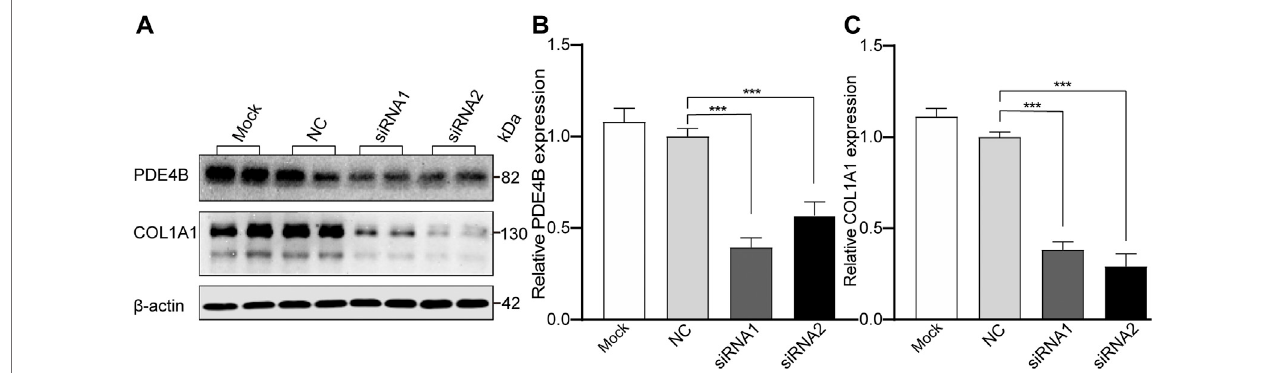
FIGURE 5 | The Effect of P DE4B Knockdown on Expression of Type I collagen (COL1A1) in cultured HSFs. The HSFs were treated with siRNA for 48 h, then the knockdownef fi ciency ofPDE4Band theexpression ofCOL1A1 wereanalyzed byWesternblot (A) . (B,C) The bar graphsrepresentrelativeprotein levels of PDE4Band COL1A1. (B) The protein expression level of PDE4B. (C) The protein expression level of COL1A1. Mock: blank control (transfection reagent only); NC, negative control (cells transfected with scrambled siRNA). β -actin was the loading control. Data were expressed as mean ± standard error (mean ± SEM), n (cid:1) 5 for each group. Comparison of the PDE4B siRNA-transfected group and scrambled siRNA group were determined by using one-way ANOVA. p- value < 0.05 was considered statistically signi fi cant (*** p <